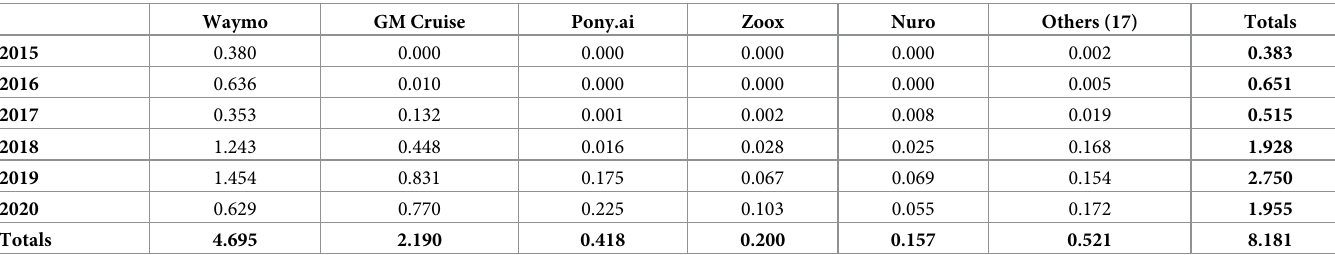
Table 1. Test companies mileages by reporting year